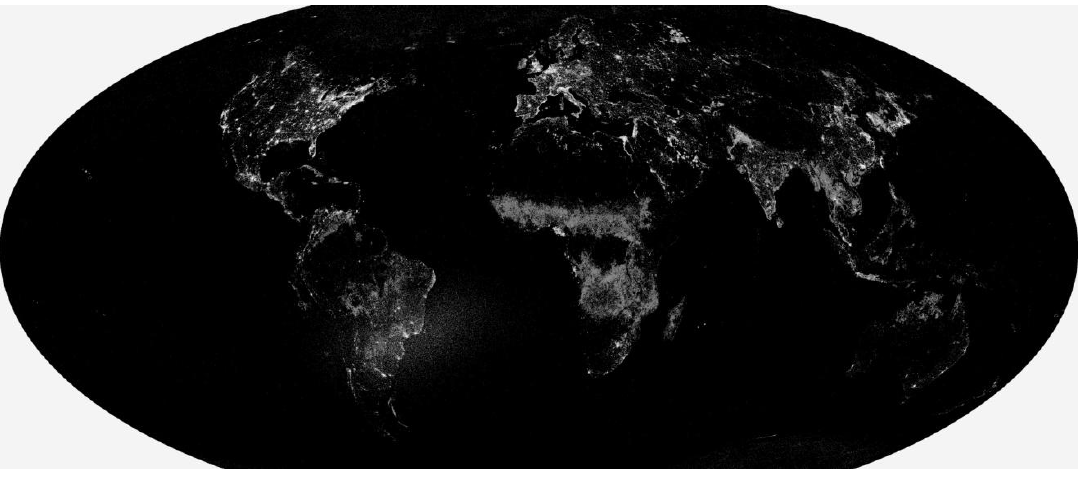
Figure 3. Mollweide equal area projection version of the DMSP nighttime lights derived from satellite F16 for year